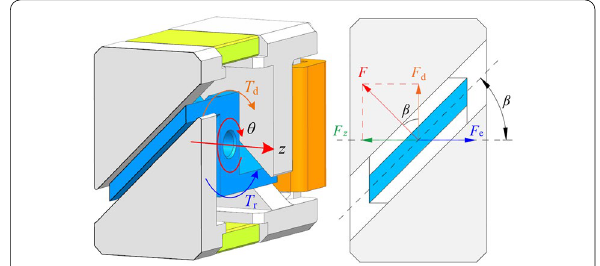
Figure 1 Schematic for structure of REMC-NFM